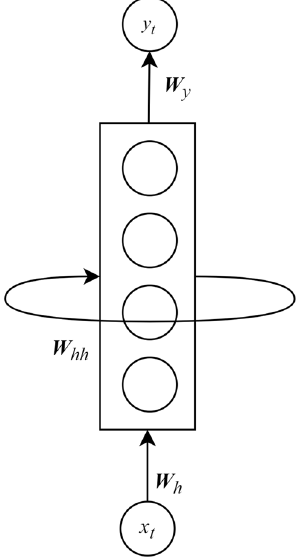
Figure 2. The physical architecture of an